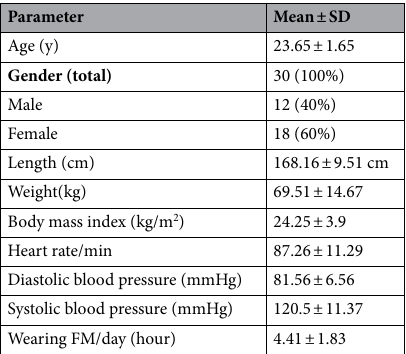
Table 1. Demographic and general data of volunteers. SD, standard deviation.